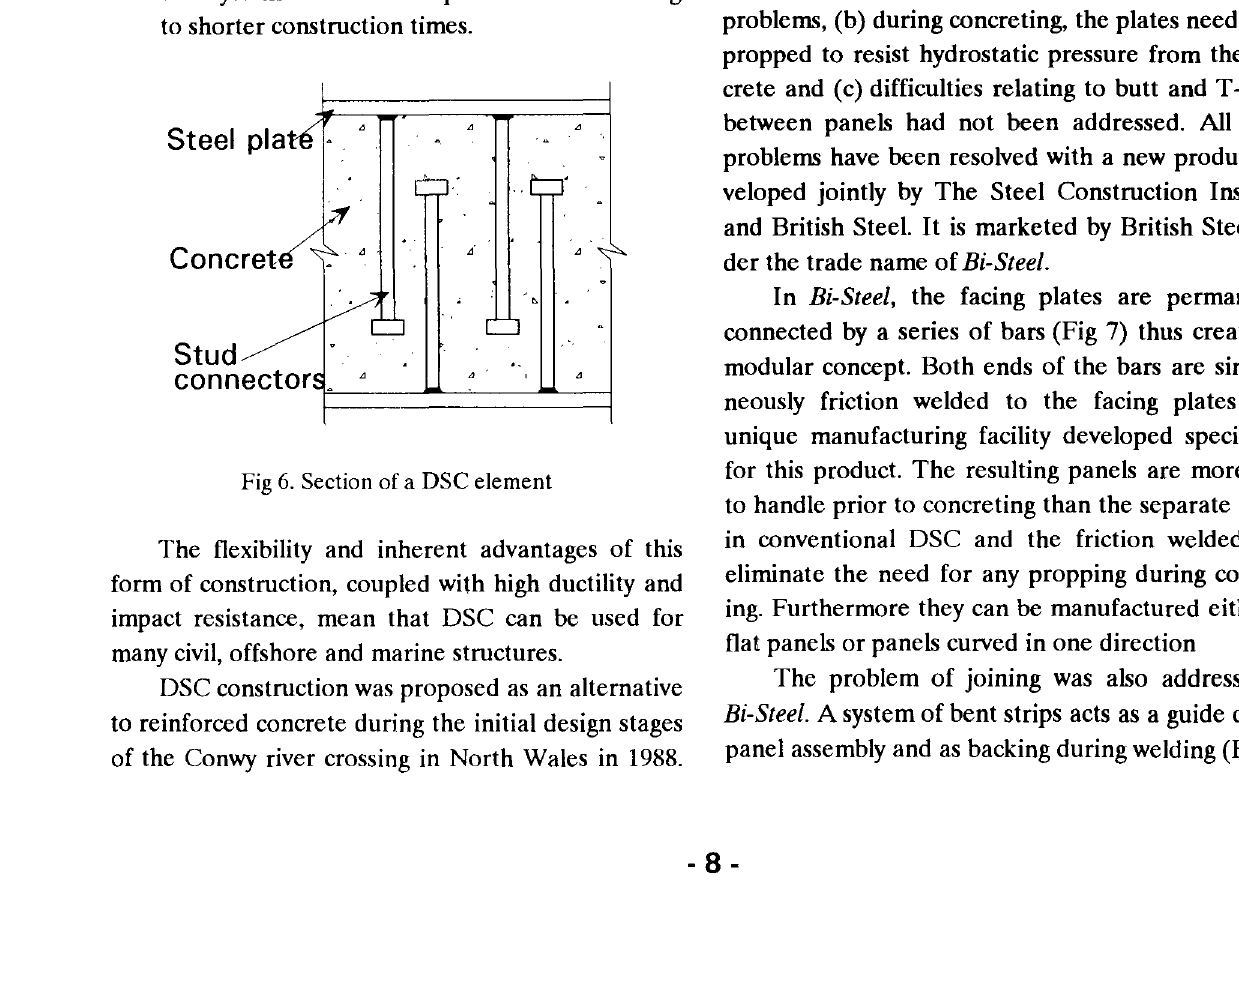
Fig 6. Section of a DSC